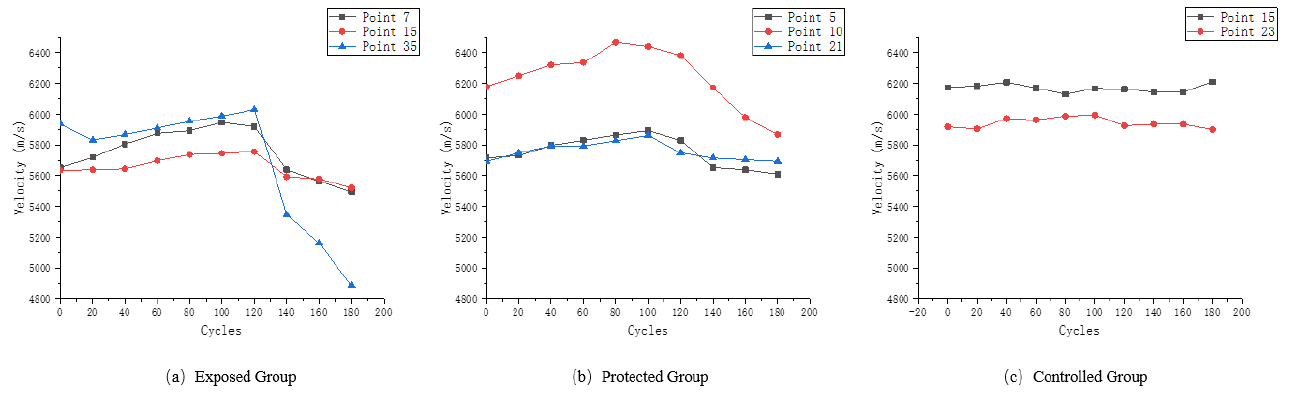
Figure 5. ( a ) Ultrasonic velocity variation of the characteristic measurement points of the exposed group; ( b ) ultrasonic velocity variation of the characteristic measurement points of the protected group; ( c ) ultrasonic velocity variation of the characteristic measurement points of the control group.